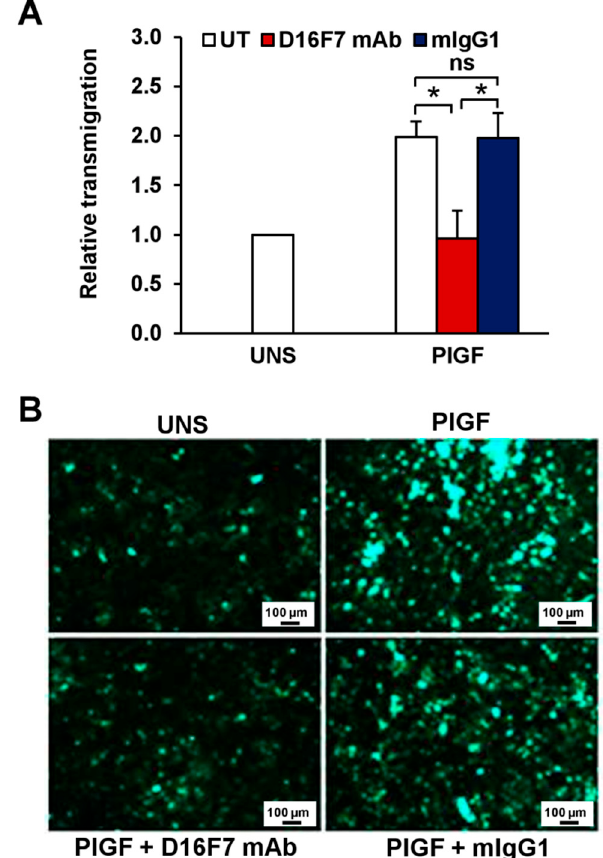
Figure 6. Inhibitory effect of D16F7 mAb on transmigration of human melanoma cells across an activated endothelial cell monolayer in response to human PlGF. ( A ) Monolayers of human endothelial cells (HUV-ST cells) were seeded on the upper side of Boyden chambers and activated with TNF- α . Human melanoma WM115 cells were labelled with calcein-AM and incubated for 30 min at room temperature in the absence (UT) or presence of 5 µ g/mL D16F7 mAb or mouse IgG as a control (mIgG1). WM115 cells (2 × 10 5 cells/chamber) were then loaded on the HUV-ST-activated monolayer and allowed to migrate for 5 h against PlGF (50 ng/mL), which was added as stimulus in the lower compartment of the Boyden chamber. Fluorescence of migrated cells was measured in four to eight fields/filter, and results were expressed as relative transmigration compared to unstimulated cells (UNS). Values in the histogram represent the mean ± SD of five Boyden chambers from three independent experiments. Statistical analysis was performed by Kruskal–Wallis test, followed by Dunn’s post hoc analysis: *, p < 0.05; ns, not significant. ( B ) Representative photographs of fluorescent WM115 cells migrated to the lower side of the filter through the endothelial monolayer are shown for each experimental condition (100× magnification). The scale bars represent 100 µ m .